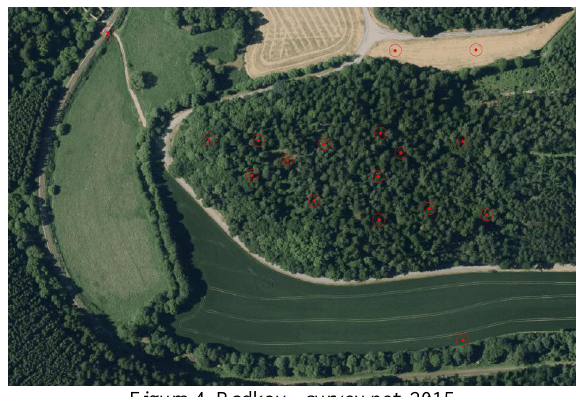
Figure 4. Radkov - survey net, 2015